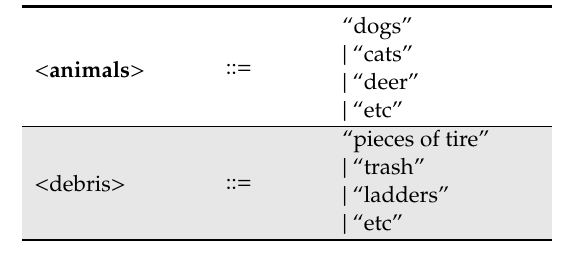
Table A10. The 4th stage of < environment >< objects >< non-roadway user obstacles / objects > .